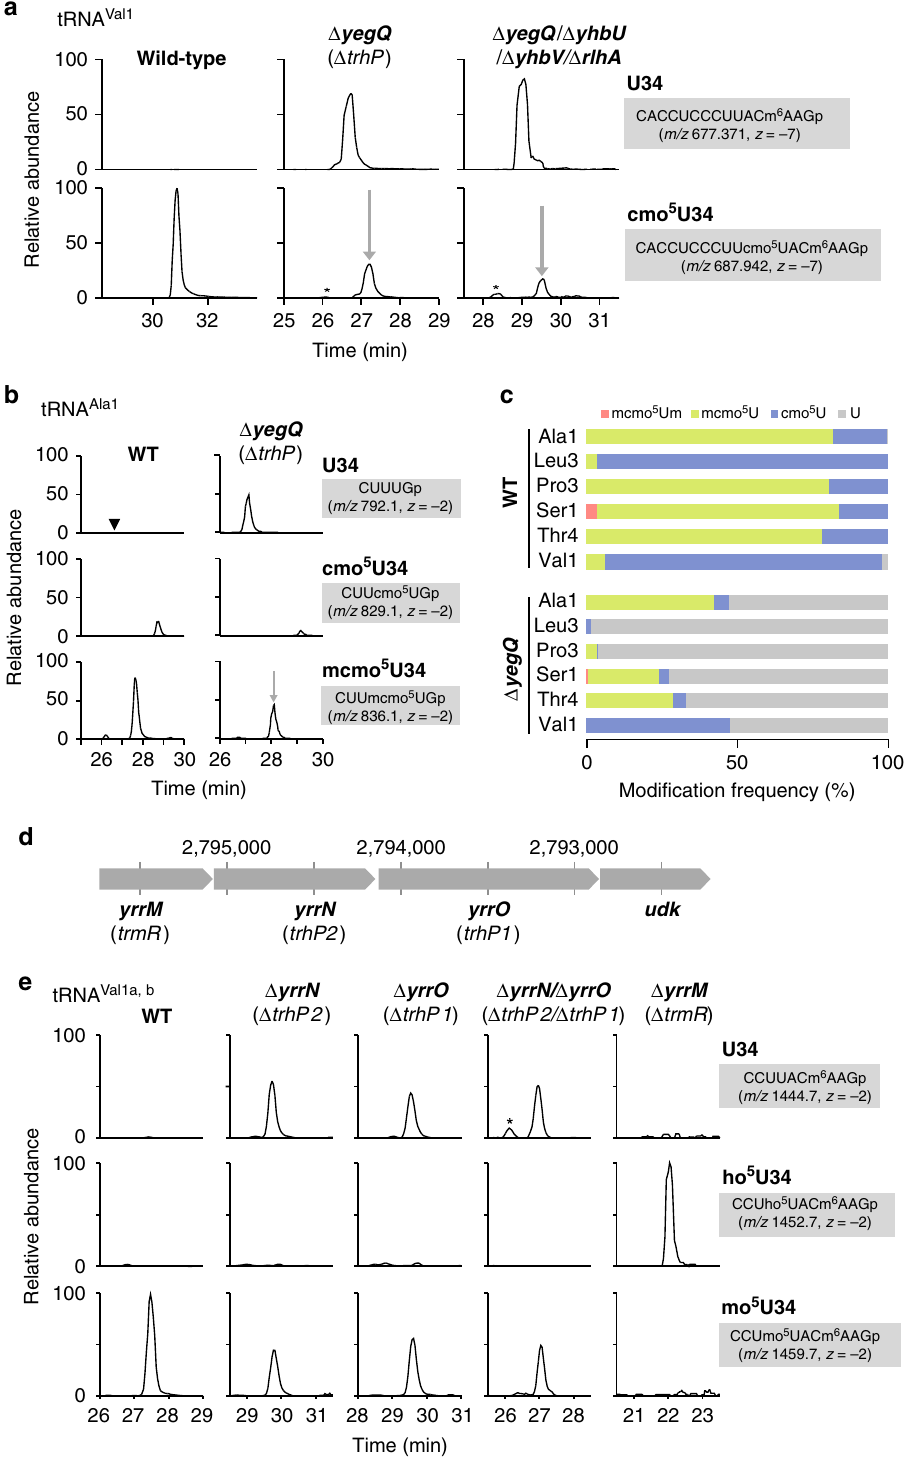
subjected to RNA-MS to analyze the anticodon-containing pathway plays a redundant role in the formation of ho 5 U34 in fragments (Fig. 2b, Supplementary Fig. 2, Supplementary Table 1). tRNAs. Hypomodi fi ed fragments were further sequenced by collision- To analyze the modi fi cation status of each tRNA species in the Δ yegQ strain, we used the reciprocal circulating chromatography induced dissociation (CID) analysis (Supplementary Fig. 3). In tRNA Ala1 , mcmo 5 U34 was present as a major wobble modi fi ca- (RCC) method 42 to isolate six tRNA species (tRNA Ala1 , tRNA Leu3 , tRNA Pro3 , tRNA Ser1 , tRNA Thr4 , and tRNA Val1 ) tion in the WT, but its levels were reduced to about 50% (concomitant with appearance of the unmodi fi ed fragment) in bearing a cmo 5 U34 or mcmo 5 U34 modi fi cation from both WT Δ yegQ (Fig. 2b). Similarly, mcmo 5 U34 levels were reduced in and Δ yegQ strains. Each tRNA was digested by RNase T 1 and NATURE COMMUNICATIONS| (2019) 10:2858